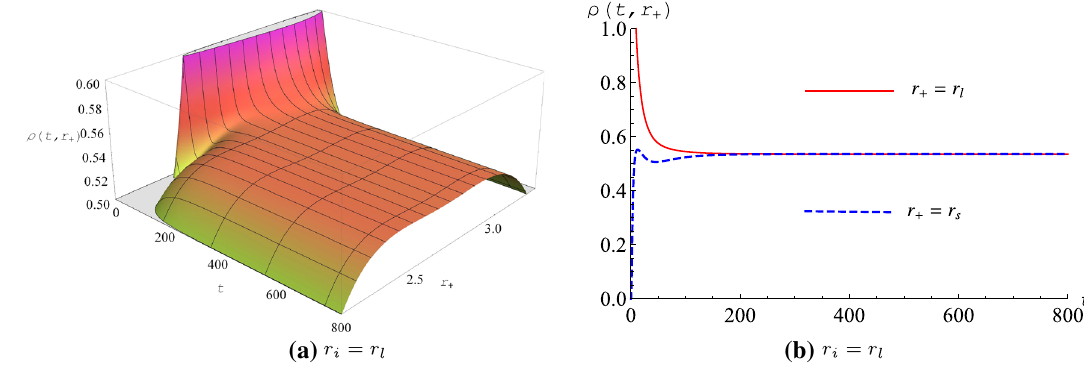
Fig. 6 ρ − t − r + with the parameters k = 1 , q = 1 , ¯ φ = 10 − 5 . The effective temperature is set to 0 . 995 T c